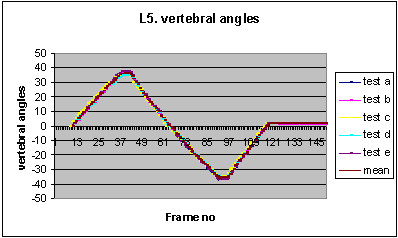
Example of a graph that met the criteria for entry into pool of intervertebral motion graphs; 5 consecutive trackings (relative to the computer's X-axis) of a series of vertebral angles that coincide visually. (acquisition at 5 f/s for 8-bit images)